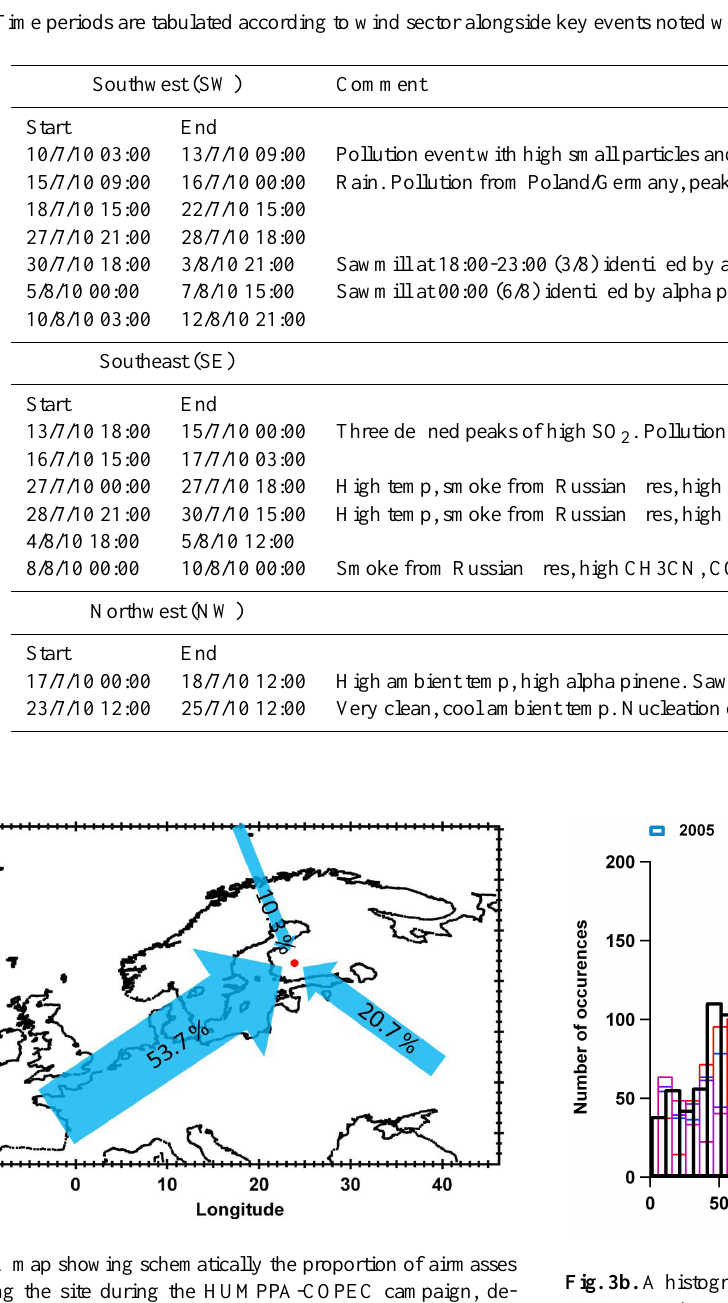
Fig. 3b. A histogram of wind direction for the HUMMPA-COPEC 2010 campaign period (5min average), compared to those taken from the years 2005–2009. Data from 16.8m on the main